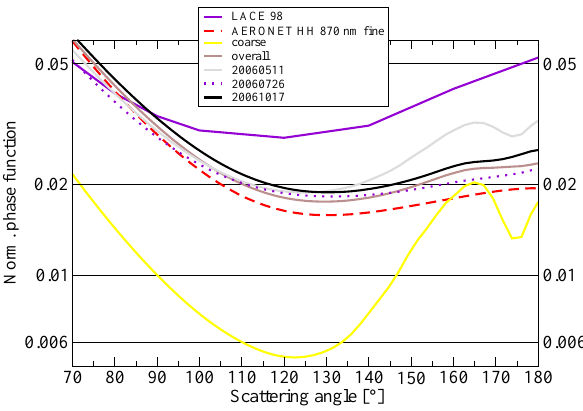
Fig. 3. Phase functions as derived from the L ACE -98 experiment; Fig. A3. Phase functions as derived from the L ACE -98 experiment; A ERONET Hamburg 870nm for fine, coarse and overall A ERONET Hamburg 870nm for fine, coarse and overall aerosols.